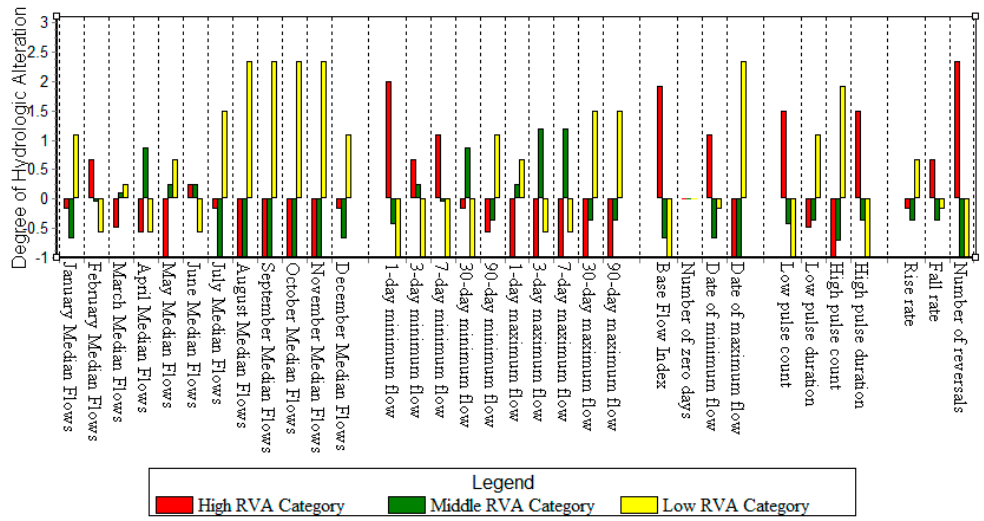
Figure 3. Hydrologic alteration of current scheduling.